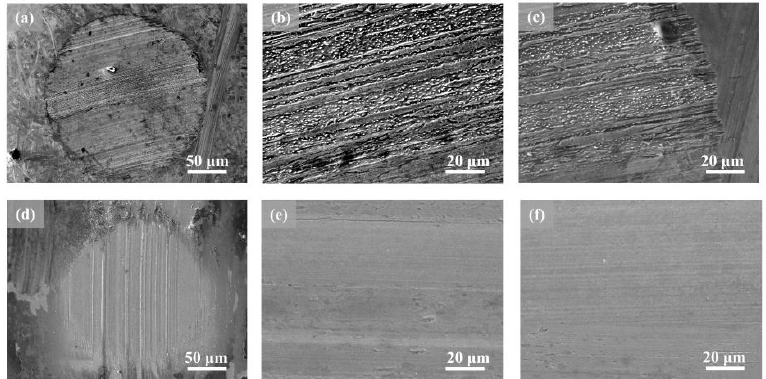
Figure 7. SEM morphologies of wear scars lubricated by ( a – c ) pure lithium grease and ( d – f ) 0.2 wt% Ni-doped lithium grease after four-ball tribology tests.